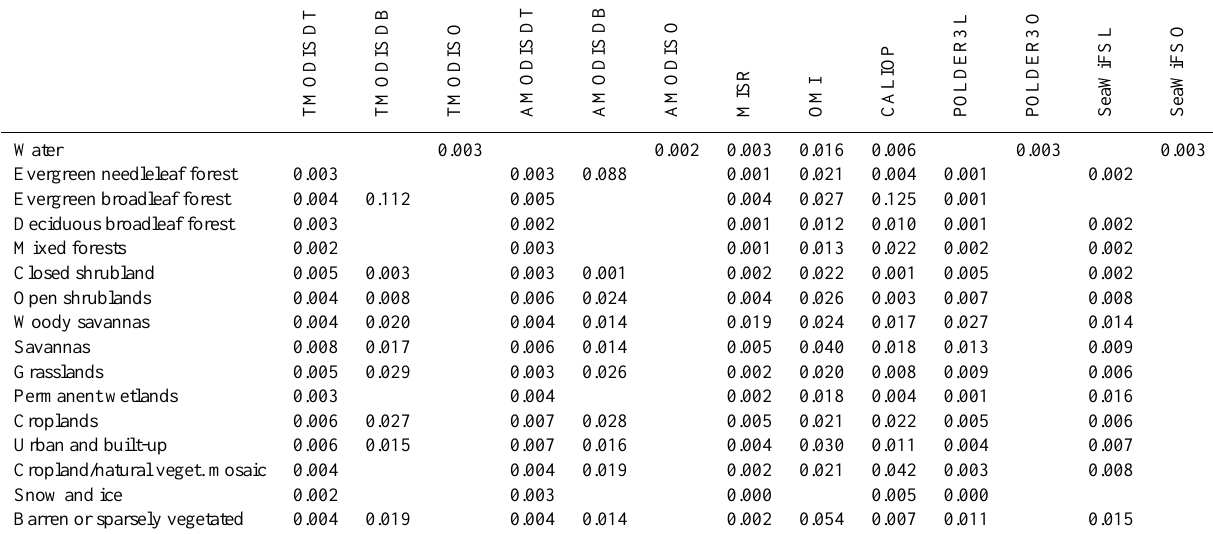
Table 7. Variance between the collocated spaceborne and ground-based observations of AOD estimated at the stations that coincide with different IGBP land cover types. Empty cells indicate no collocated data available from a specific sensor over a specific land cover type. No AERONET stations are available at the areas occupied by Deciduous needleleaf forest. The statistics were calculated based on the data that were pre-filtered by QA and screened of outliers as described in Sects. 4 and 5. A graphical representation of this table is in Fig. 14. Please see the Supplement for a breakdown of the listed statistics based on the nominal boreal